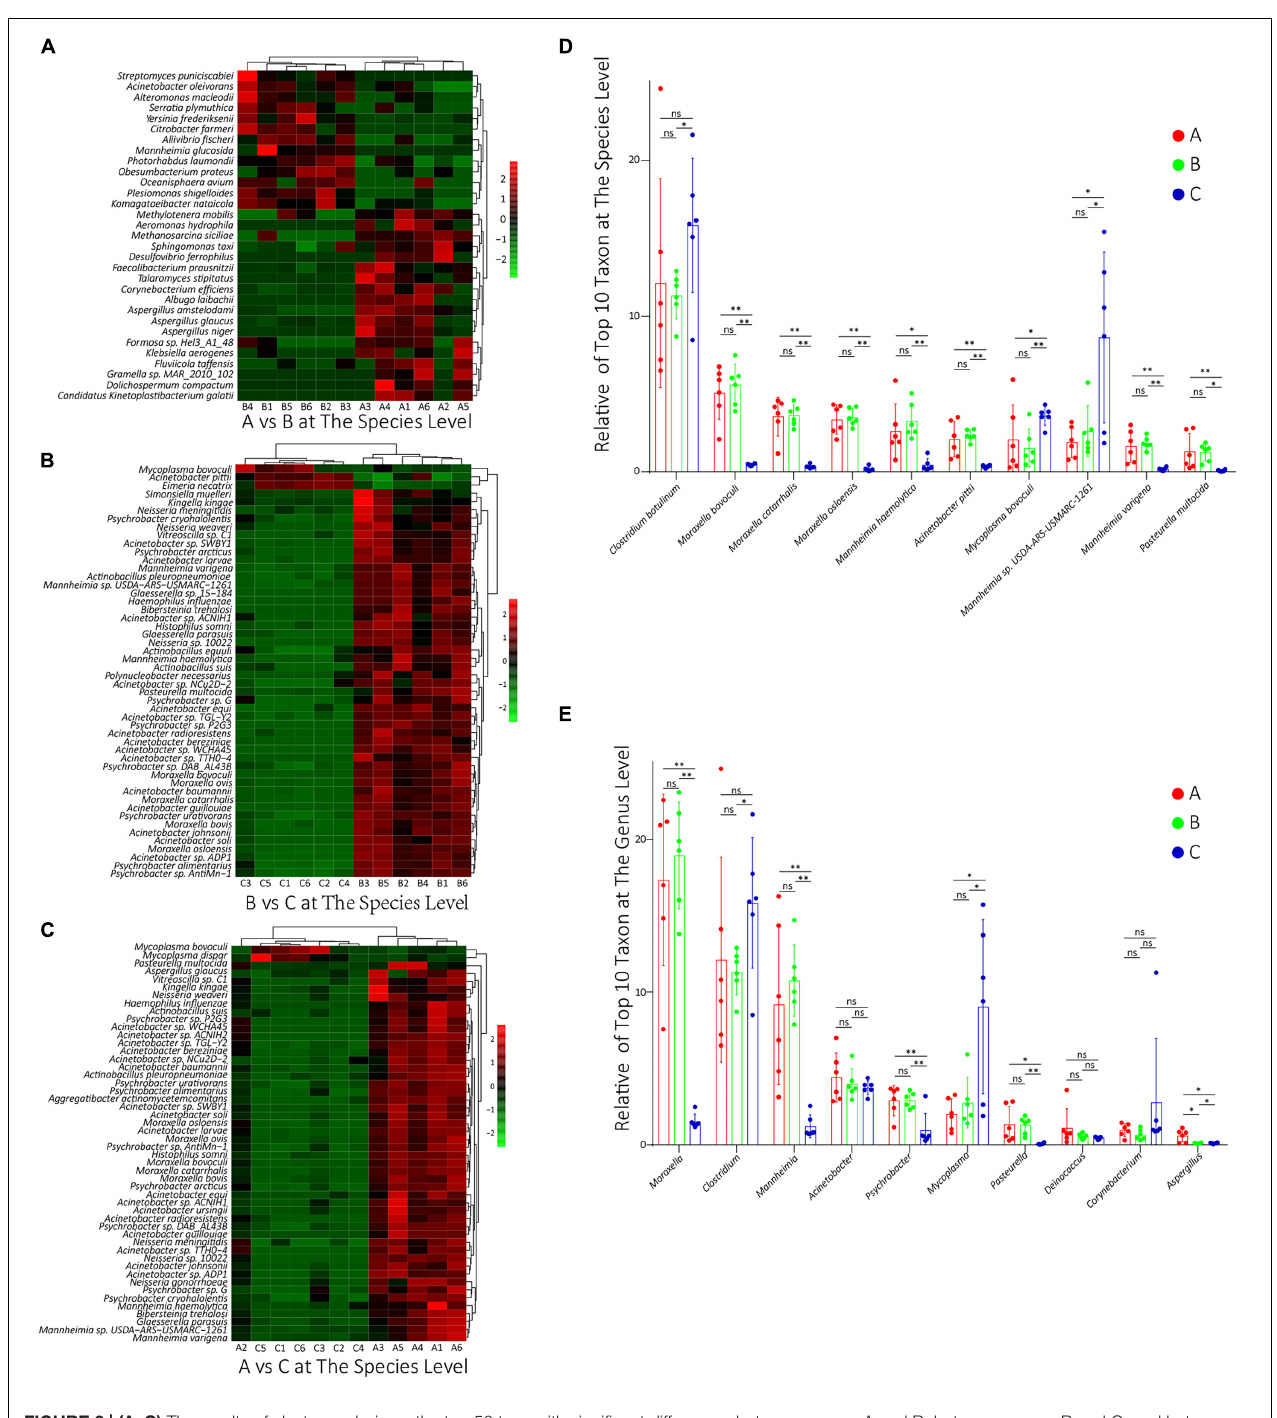
FIGURE 3 | (A–C) The results of cluster analysis on the top 50 taxa with significant differences between groups A and B, between groups B and C, and between groups A and C, respectively, at the species level. The red box denotes that the relative abundance was higher, and the green box indicates that the relative abundance was lower. (D,E) The relative abundance of these top 10 species and genus, respectively, in all groups. ns: non-significant; ∗ 0.01 < p < 0.05; ∗∗ p <